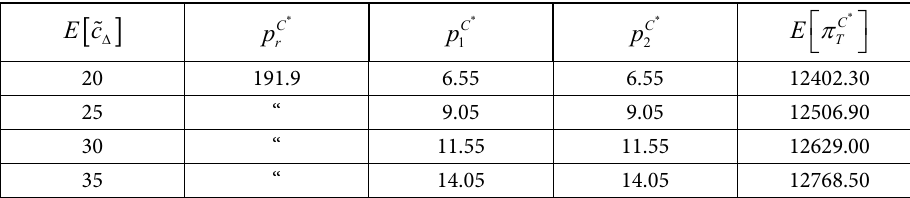
Table 5. Centralized decision-making with the change of expected value of c ∆ 